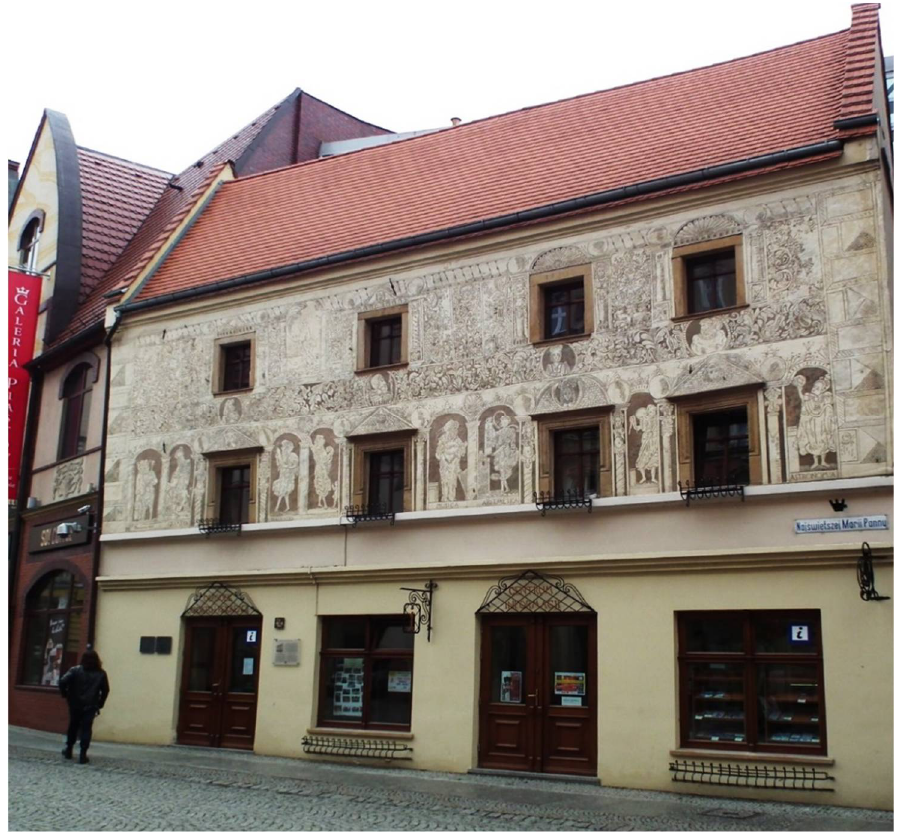
Figure 32. Sgraffito decorations at the Scholz (Scultetus) House in Legnica. Photo MOs810, 2015. Source: Wikipedia. Kamienica Scultetusa w Legnicy.